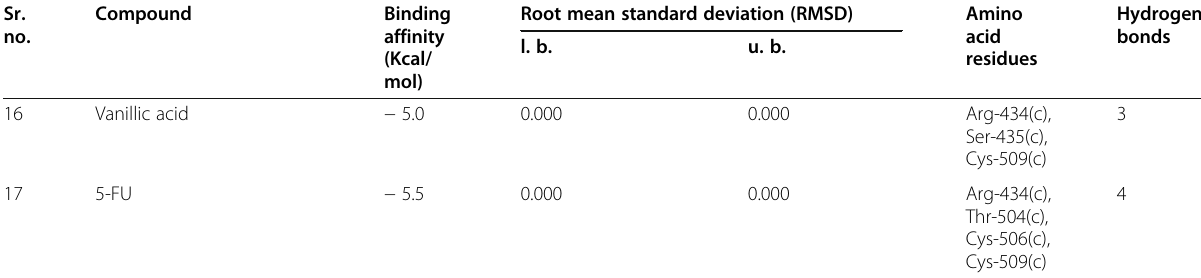
Table 2 Molecular docking studies of phytoconstituents found in C. zeylanica Linn. leaves (Continued) Sr. no.